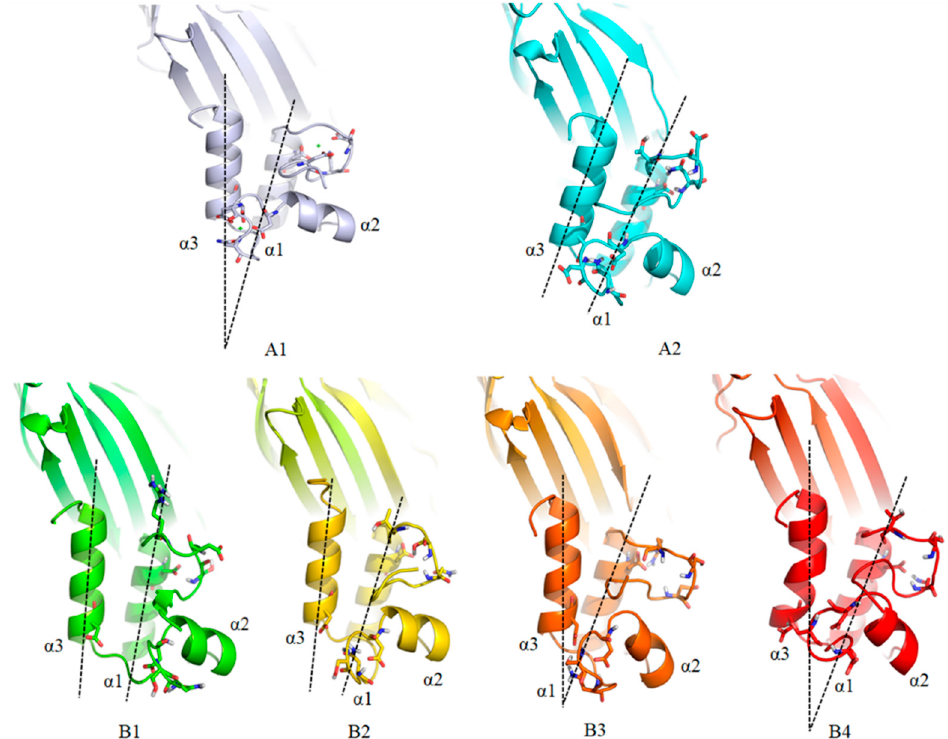
Figure 4. Comparison of DocA mutants and Coh simulation structures. ( A1 ) The structure of original DocA and Coh in the presence of Ca 2+ . ( A2 ) The structure of original DocA and Coh in the absence Ca 2+ . ( B1 ) The structure of DocA-D1 and Coh in the absence of Ca 2+ . ( B2 ) The structure of DocA-D2 and Coh in the absence of Ca 2+ . ( B3 ) The structure of DocA-D3 and Coh in the absence of Ca 2+ . ( B4 ) The structure of DocA-D4 and Coh in the absence of Ca 2+